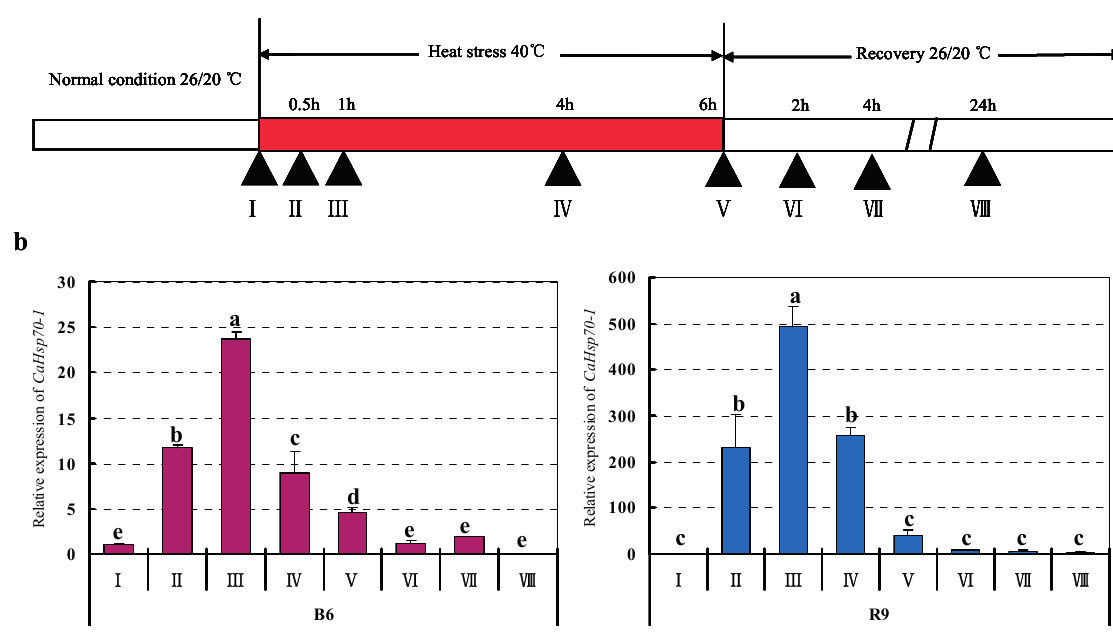
Figure 6. Expression of CaHsp70-1 in pepper leaves treated with exogenous